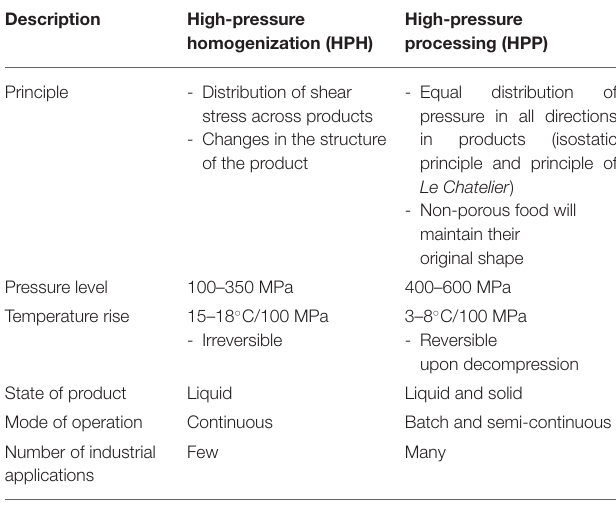
TABLE 1 | Summary of distinguishing high-pressure homogenization from high-pressure